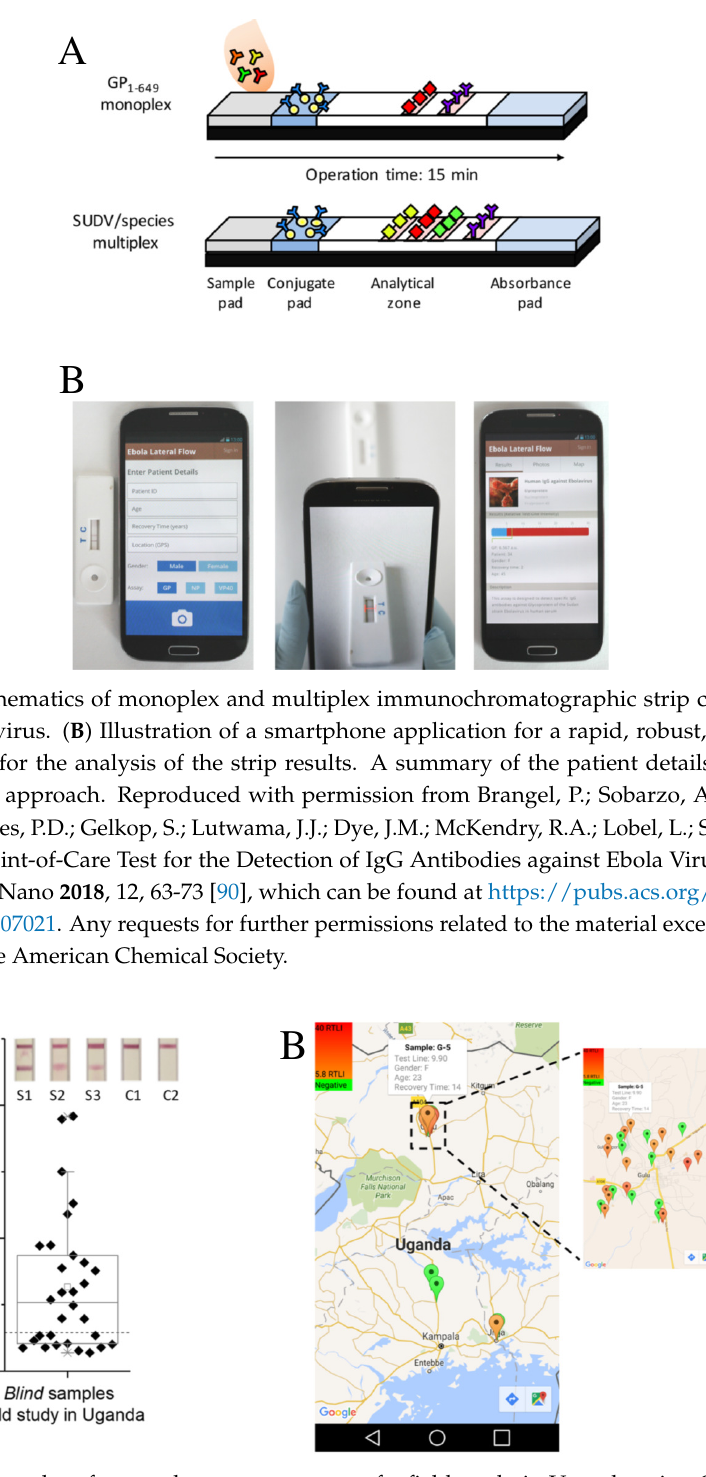
Figure 10. ( A ) Box plot of monoplex measurements of a field study in Uganda using GP 1 − 649 . The inset shows the microfluidic strips of three survivors (S1–S3) and two noninfected controls (C1–C2). ( B ) Map distribution for on-site testing of survivors of 2015 collection in Uganda. Reproduced with permission from Brangel, P.; Sobarzo, A.; Parolo, C.; Miller, B.S.; Howes, P.D.; Gelkop, S.; Lutwama, J.J.; Dye, J.M.; McKendry, R.A.; Lobel, L.; Stevens, M.M. A Serological Point-of-Care Test for the Detection of IgG Antibodies against Ebola Virus in Human Survivors. ACS Nano 2018 , 12, 63-73 [90], which can be found at https://pubs.acs.org/doi/full/10.1021/acsnano.7b07021. Any requests for further permissions related to the material excerpted should be directed to the American Chemical